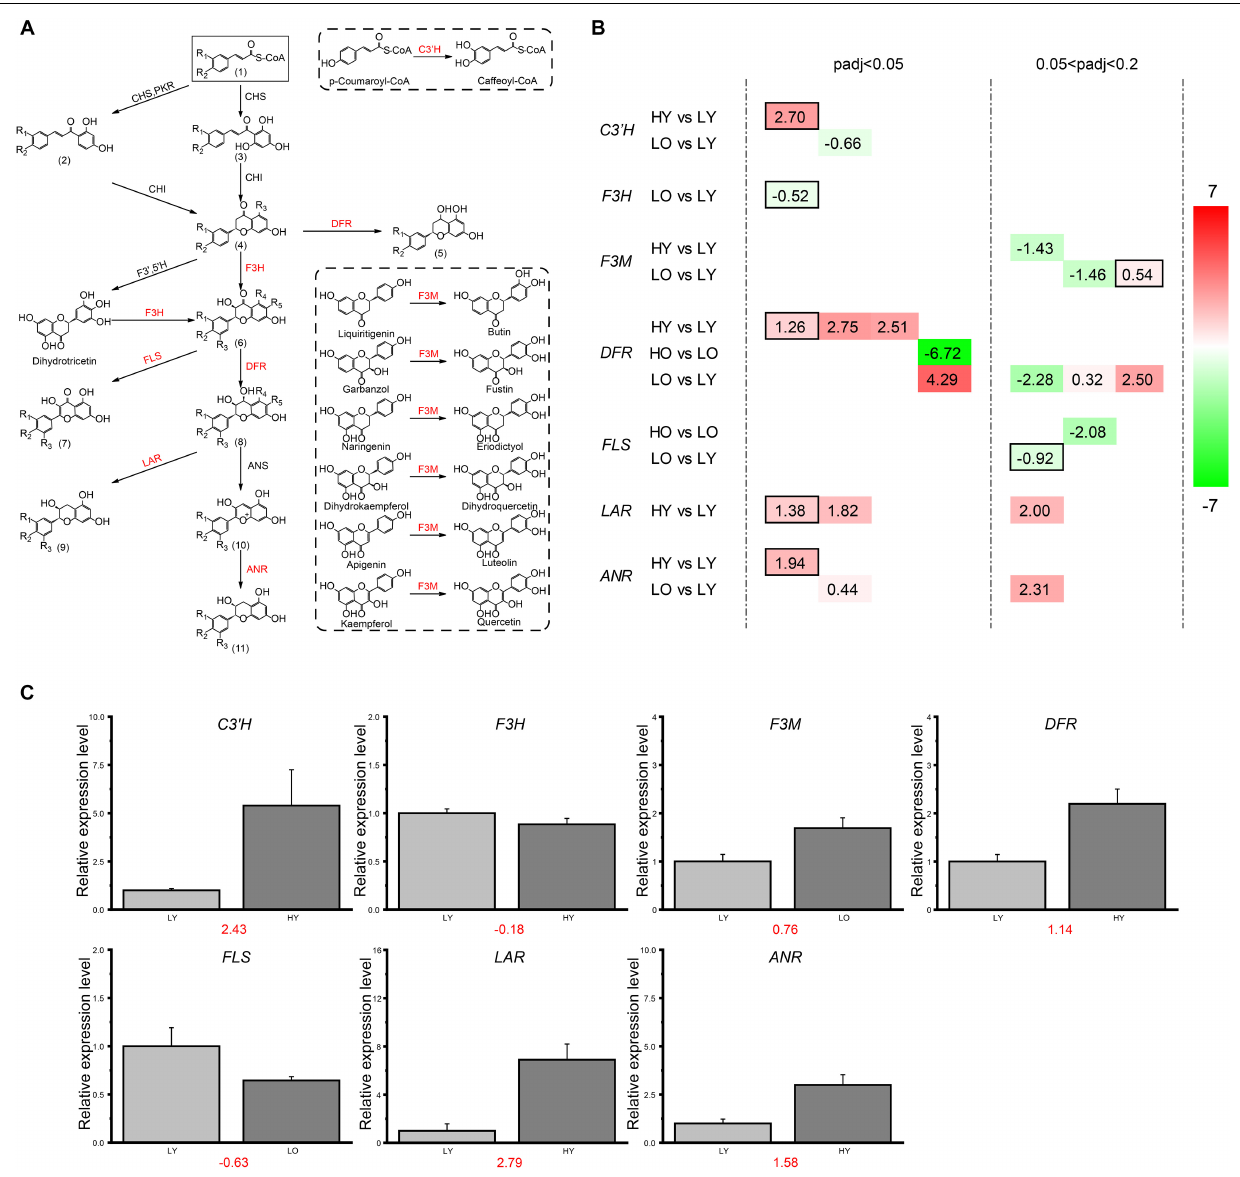
vs. LY at a young plant age level. However, when plant age became older in HO vs. LO, only one putative DFR unigene and one putative FLS unigene were both down-regulated with the increase of elevation. The situation was much more complicated